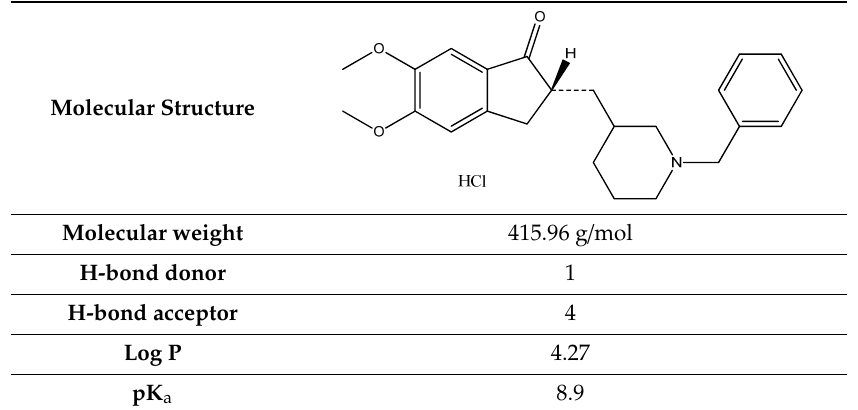
Table 1. Molecular structure and essential properties of donepezil hydrochloride (DH).